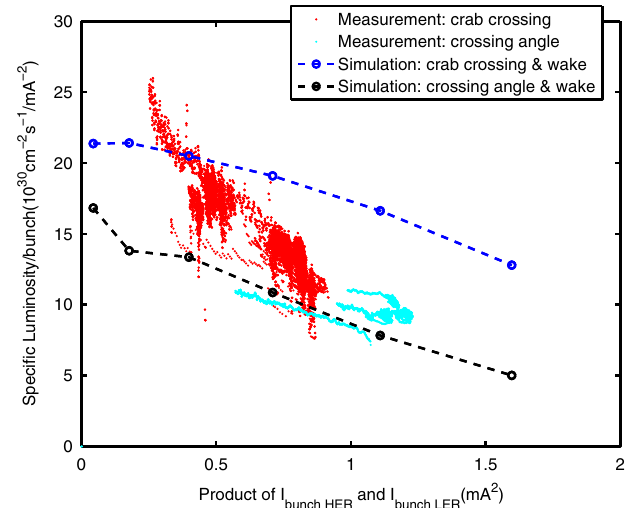
FIG. 9. (Color) Comparison of measured and simulated specific luminosity as a function of the product of bunch currents with/ without crab cavities.